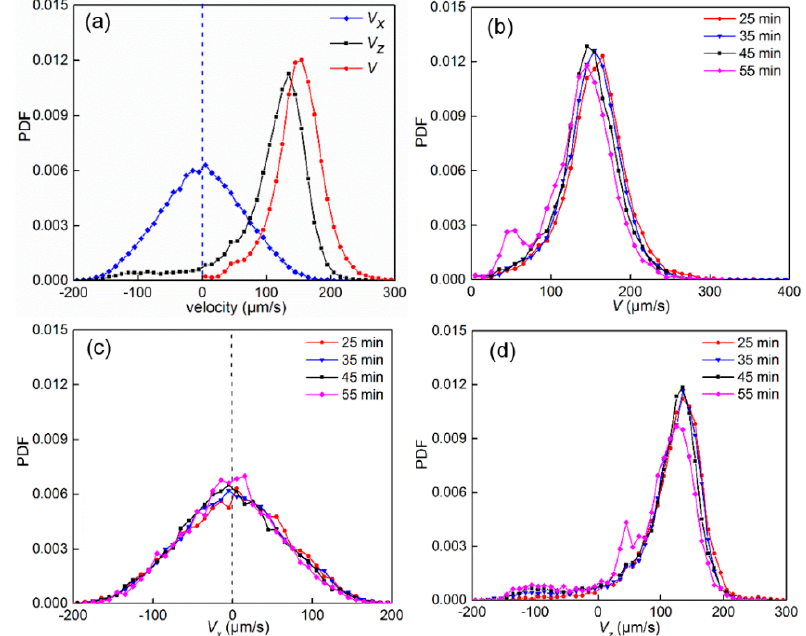
Figure 5. Distribution of probability density of swimming velocity: ( a ) f ( V ), f ( V x ), and f ( V z ) in all tests, ( b ) f ( V z ) at different time, ( c ) f ( V x ) at different time, and ( d ) f ( V ) at different time.